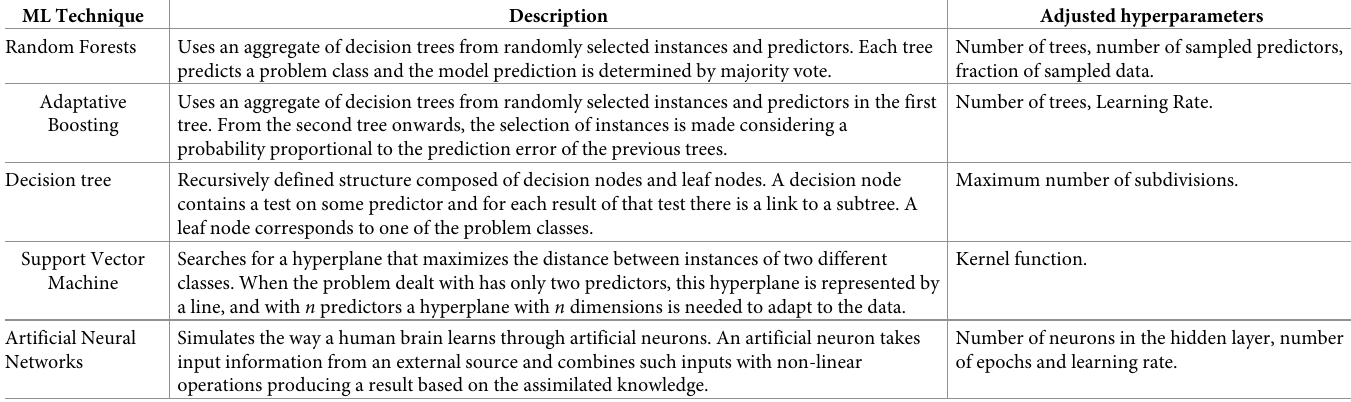
Table 1. Description of Machine Learning (ML) techniques adopted in the